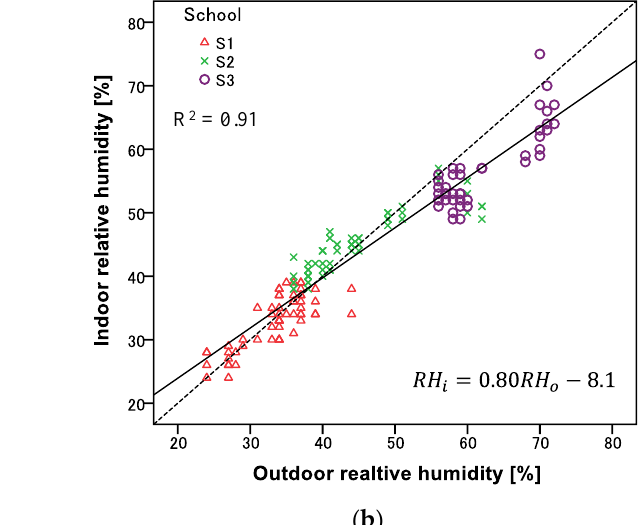
Figure 8. Measurement during the voting time in S1, S2, and S3 buildings: ( a ) indoor globe and outdoor air temperatures and ( b ) indoor and outdoor relative humidity.